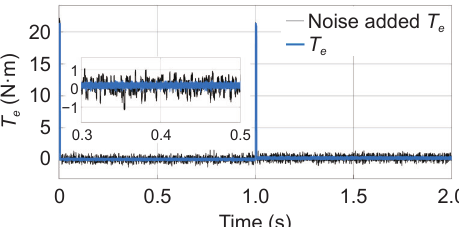
before and after noise being added. e